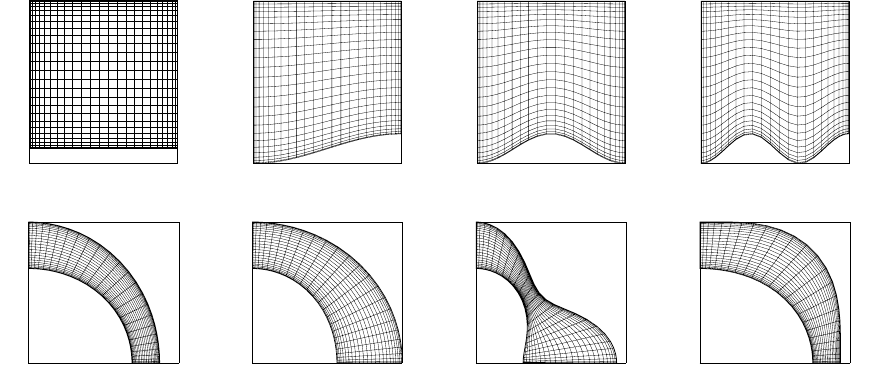
Figure 4. The deformed pipes used to construct the basis functions for the pipe